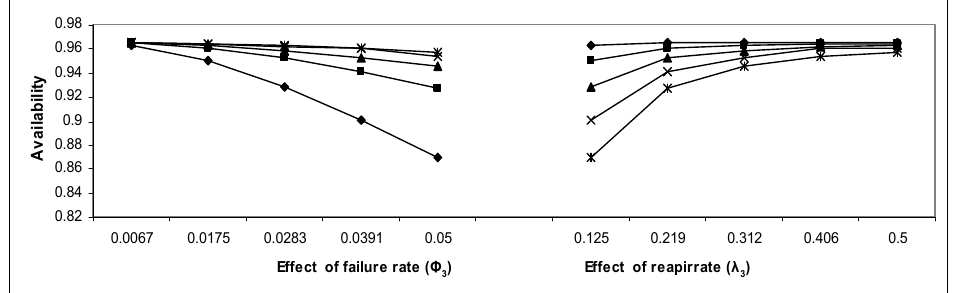
Figure 4. “Effect of failure & repair rate of FD fans Subsystem on subsystem